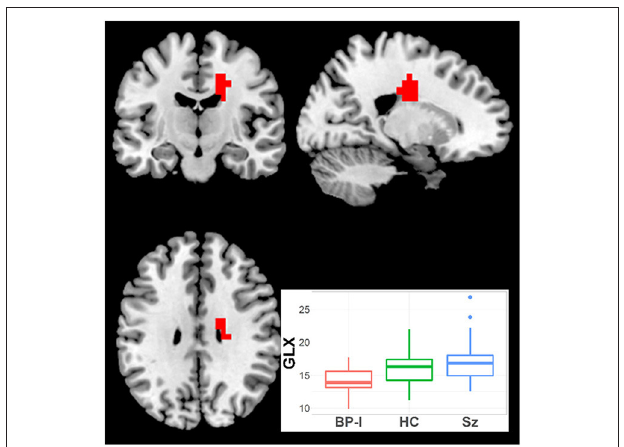
FIGURE 2 | Increased Glx in Schizophrenia (Sz) vs. Bipolar-I (BP) (healthy controls [HC] intermediate) in one cluster (19 voxels), CCLAV = 0.05, including the right cingulate gyrus (60.3%). Boxplot shows weighted-average Glx cluster concentrations in institutional units.